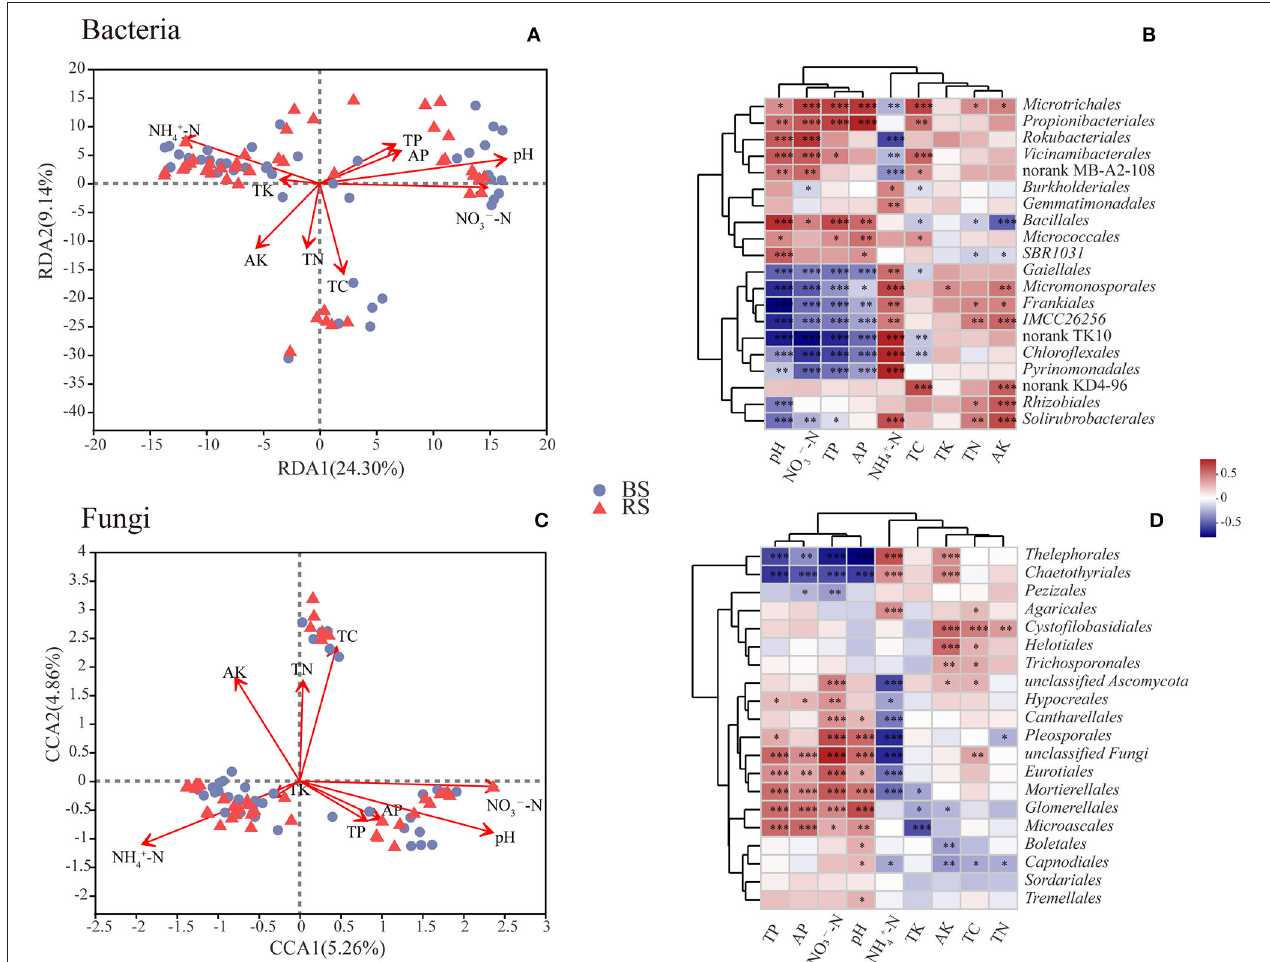
FIGURE 6 | Correlations between microbial communities and soil chemical properties. (A,C) RDA/CCA results of the relationship between bacteria/fungi community structure and soil chemical properties. Different colored or shaped dots in the graph indicate groups of samples in different environments, and arrows indicate environmental factors. The length of the line between the arrow and the origin represents the degree of correlation between an environmental factor and the distribution of communities, and the longer the line, the higher the correlation. The angle between the arrow and the ranking axis represents the correlation between an environmental factor and the ranking axes, and the smaller the angle, the higher the correlation. BS and RS, bulk soil and rhizosphere soil, respectively. (B,D) Correlation analysis results between the relative abundance of dominant soil microorganisms at the order level and soil chemical properties. The graphs show the top 20 orders in the relative abundances. The horizontal and vertical axes show the soil chemical properties and species, respectively. Spearman’s correlation coefficients are shown in different colors in the graphs. *, **, and *** Indicate 0.01 < p < 0.05, 0.001 < p < 0.01, and p < 0.001, respectively. TC, TN, TP, and TK, total contents of carbon, nitrogen, phosphorus, and potassium, respectively; NH + 4 -N and NO − 3 -N, ammonium nitrogen and nitrate nitrogen; AP and AK, active contents of phosphorus and potassium,